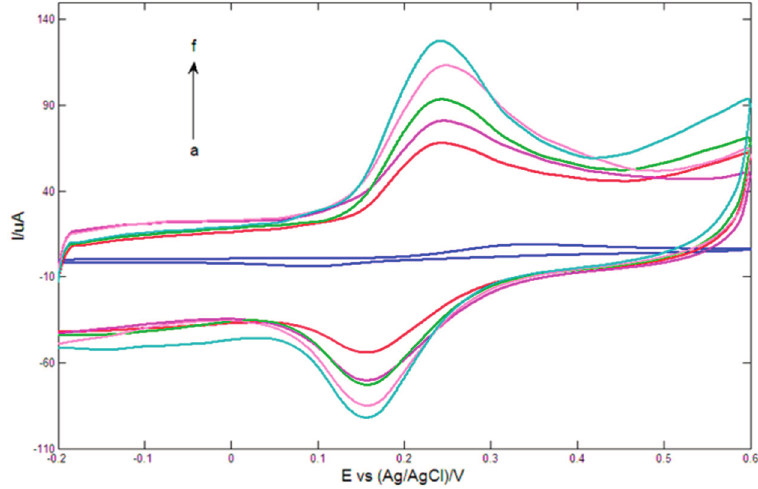
Figure 4. Cyclic voltammetrys of bare GCE ( a ); PtNPs-GR/GCE ( b ); AuNPs-GR/GCE ( c ); Au1Pt2NPs-GR/GCE ( d ); Au2Pt1NPs-GR/GCE ( e ) and Au1Pt1NPs-GR/GCE ( f ) in 0.1 M PBS (pH = 7.0) containing 0.2 mM DA. Scan rate: 100